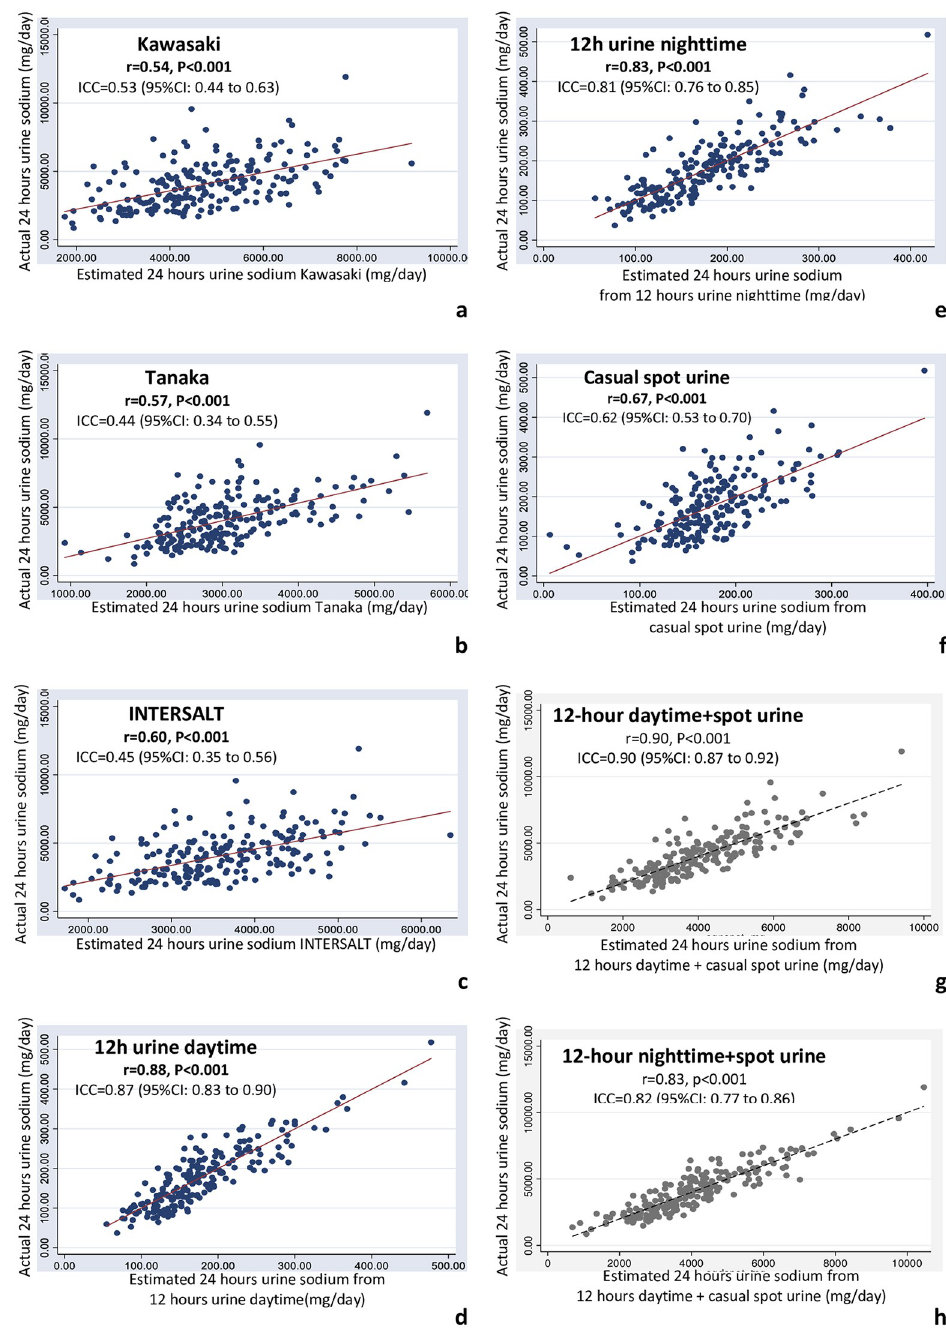
Fig 2. Correlation between the actual and the estimated equation 24 hours sodium excretion: (a) from Kawasaki equation, (b) from Tanaka equation, (c) from INTERSALT equation, (d) novel equation from 12-hour urine daytime collection, (e) novel equation from 12-hour urine nighttime collection, (f) novel equation from casual spot urine collection, (g) novel equation from 12-hour urine daytime collection with casual spot urine collection, (h) novel equation from 12-hour urine nighttime collection with casual spot urine